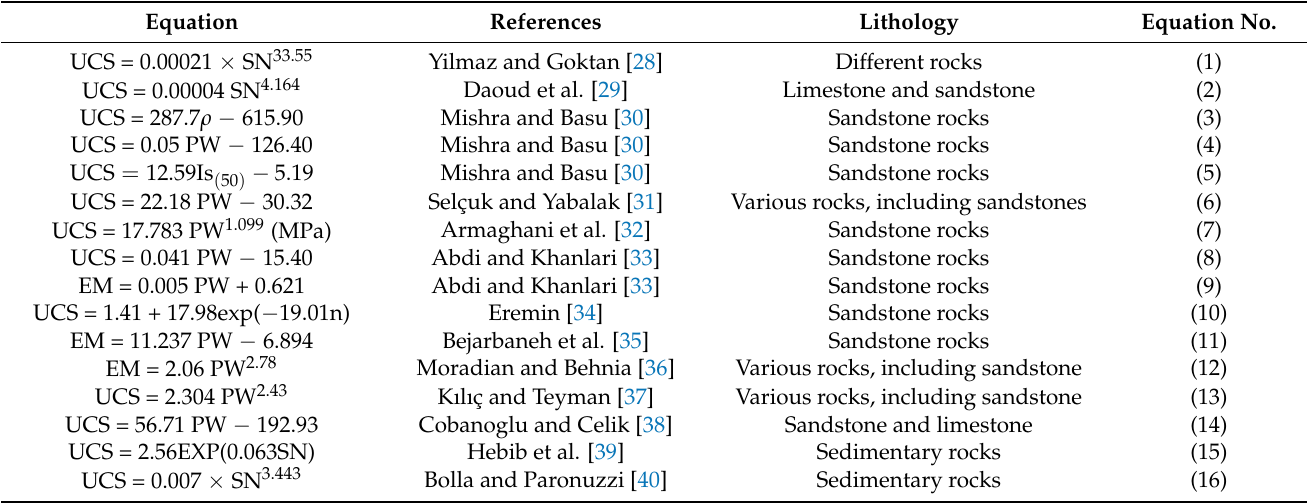
Table 1. Suggested equations for forecasting UCS and EM of sedimentary rocks.